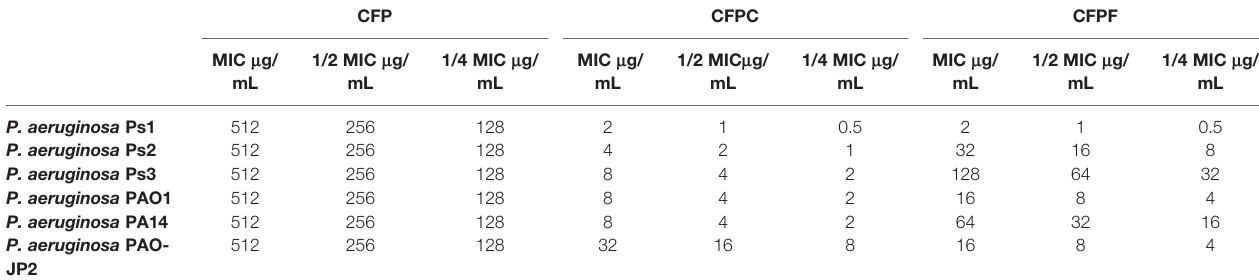
TABLE 3 | MICs and sub-MICs; 1/2 and 1/4 of Cefoperazone (CFP), Cefoperazone-Cobalt complex (CFPC) and Cefoperazone-Iron complex